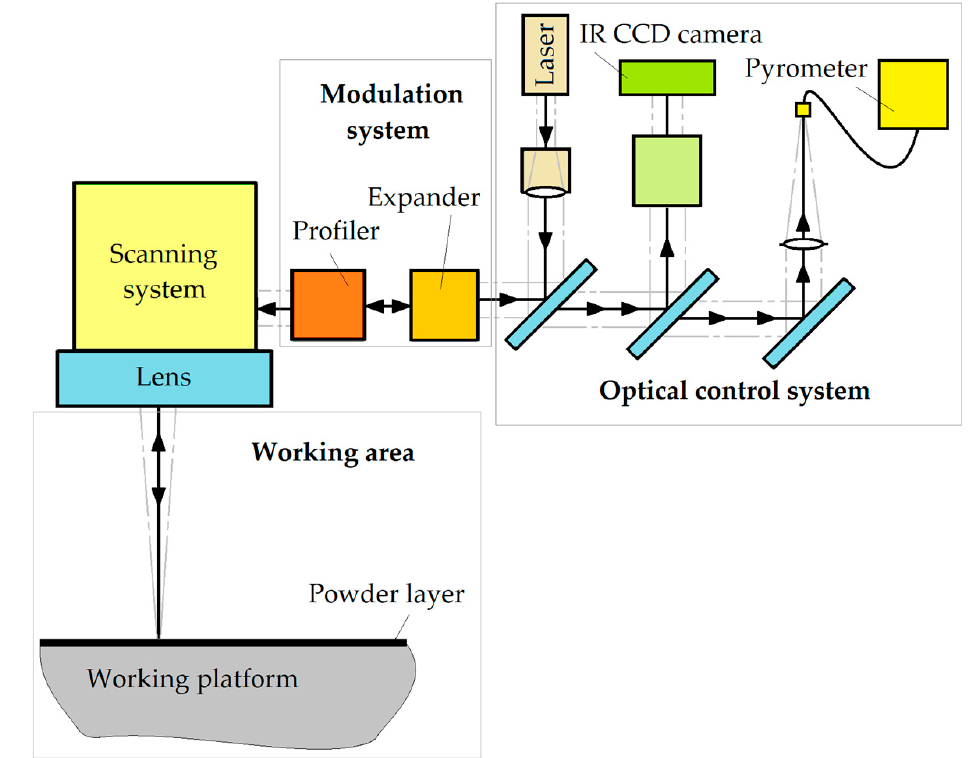
Figure 13. Modulation and optical control systems in-build into LPBF setup.